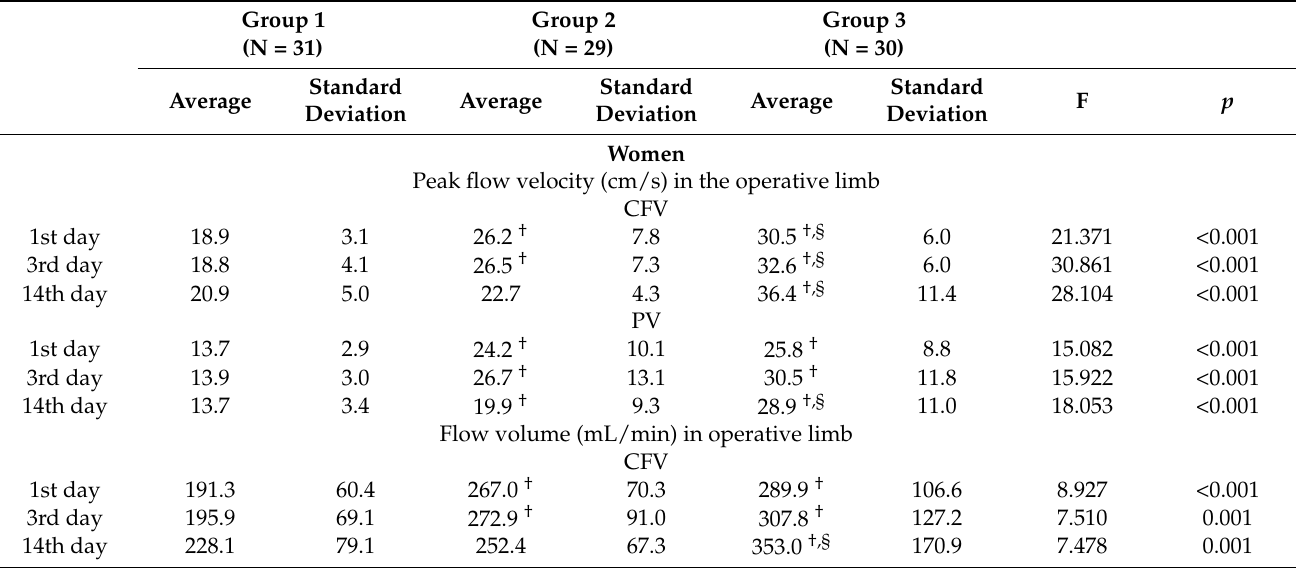
Table 4. Peak flow velocity and flow volume in the common femoral vein (CFV) and popliteal vein (PV) after the surgery stratified by